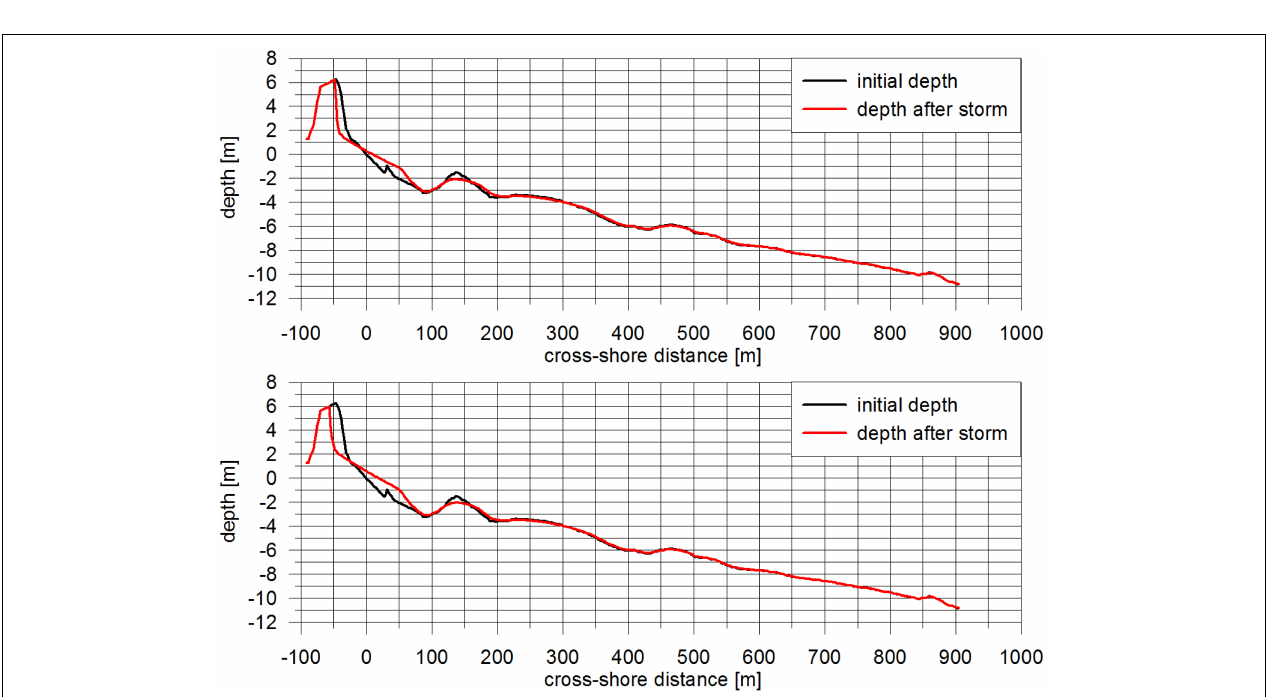
FIGURE 7 | Results of simulation of storm effect for Kopa´n barrier, km 266, total surge 1.3 m.